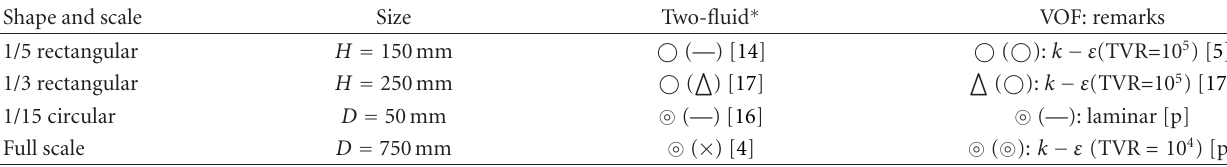
Figure 9: Results calculated using the laminar model for the 1/5-scale tests ( D = 50 mm, air-water). Table 2: Summary of CCFL